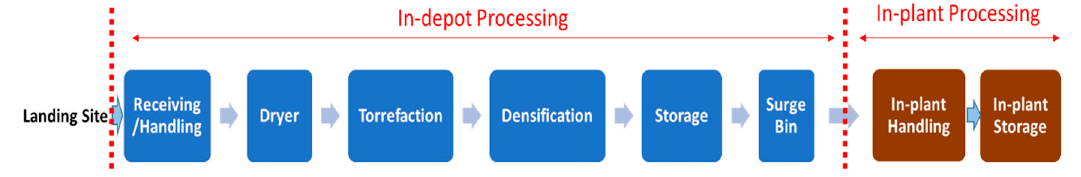
Figure 1. Processes in advanced woody biomass logistics.